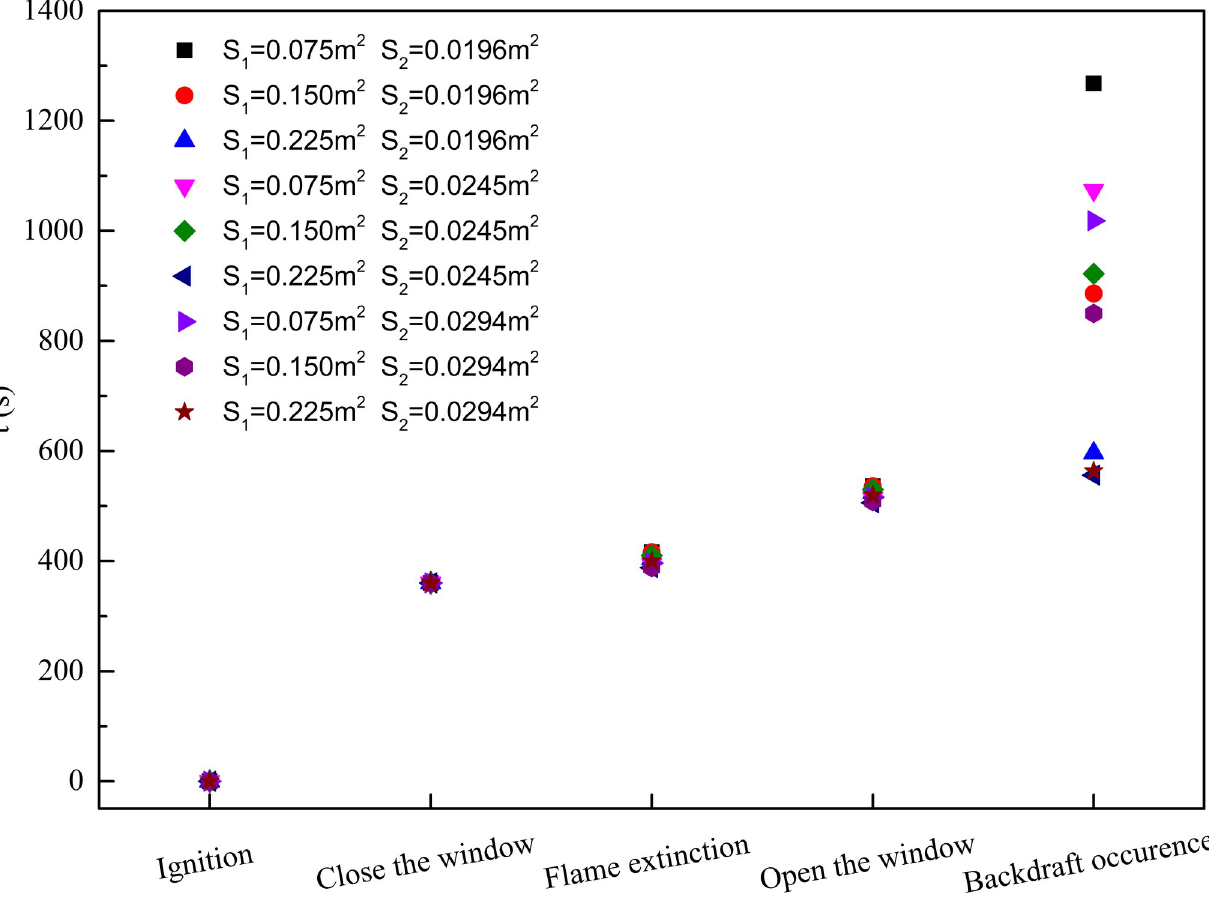
Fig 6. The corresponding times of the experimental